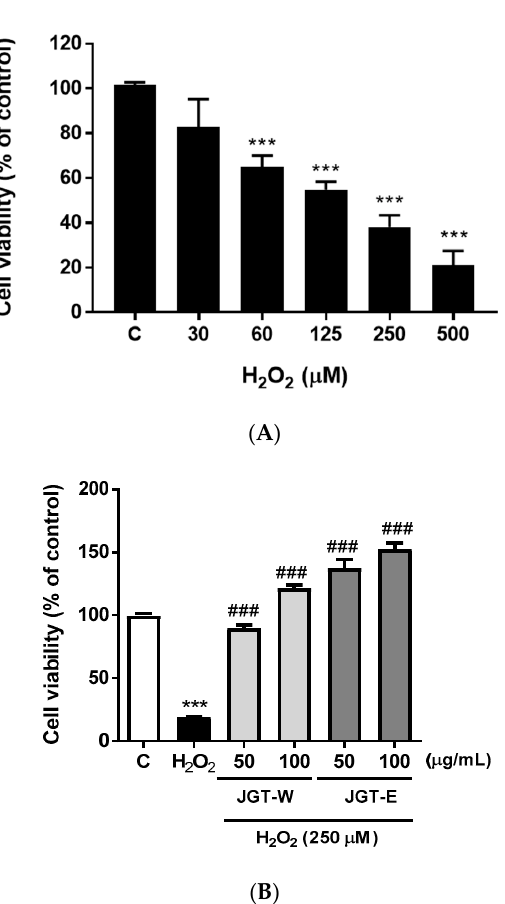
Figure 4. Effects of JGT-W and JGT-E on growth of H 2 O 2 -treated C2C12 cells. ( A ) H 2 O 2 -induced C2C12 death. ( B ) Protective effects of JGT-W and JGT-E in C2C12 against H 2 O 2 -induced